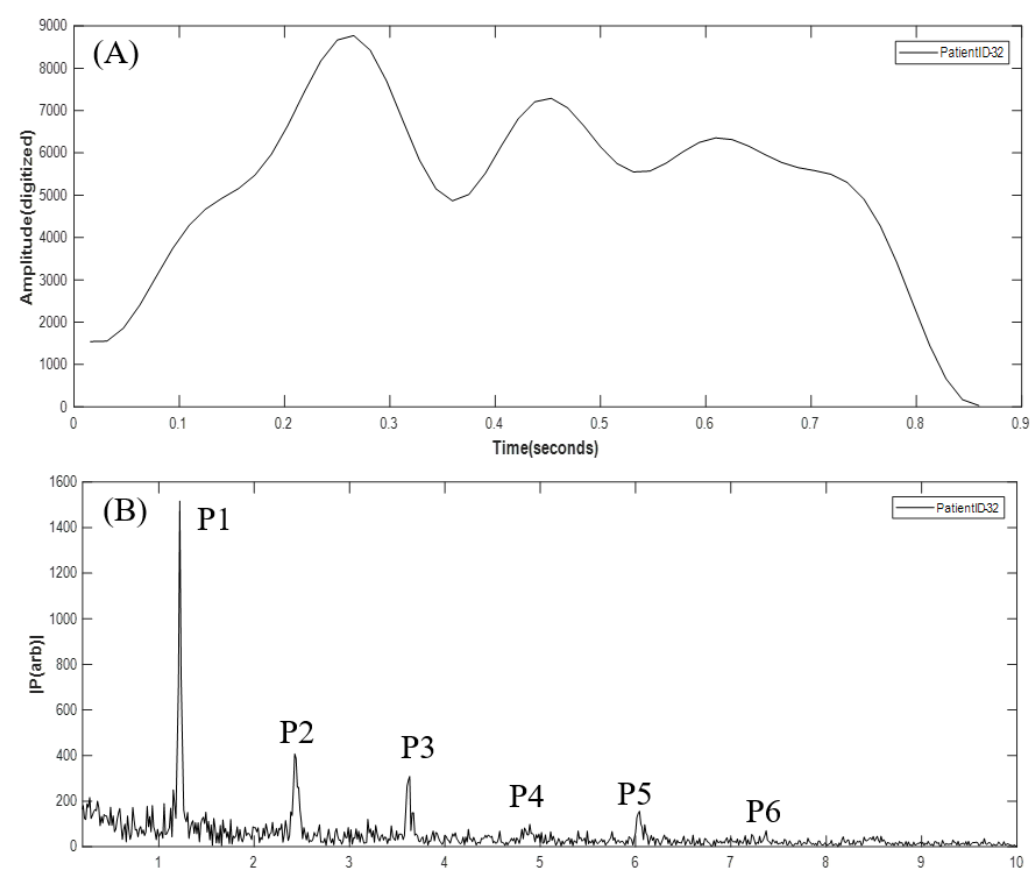
Figure 7. ( A ) Abnormal oscillations superimposed on one cycle of the VWM waveform. ( B ) The abnormal FFT spectrum with more pronounced spectral peaks at P3 and P5.